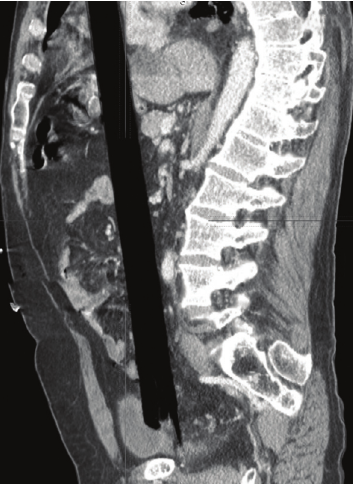
Figure 1: Sagittal CT radiograph showing the splintered end of the impaled object.